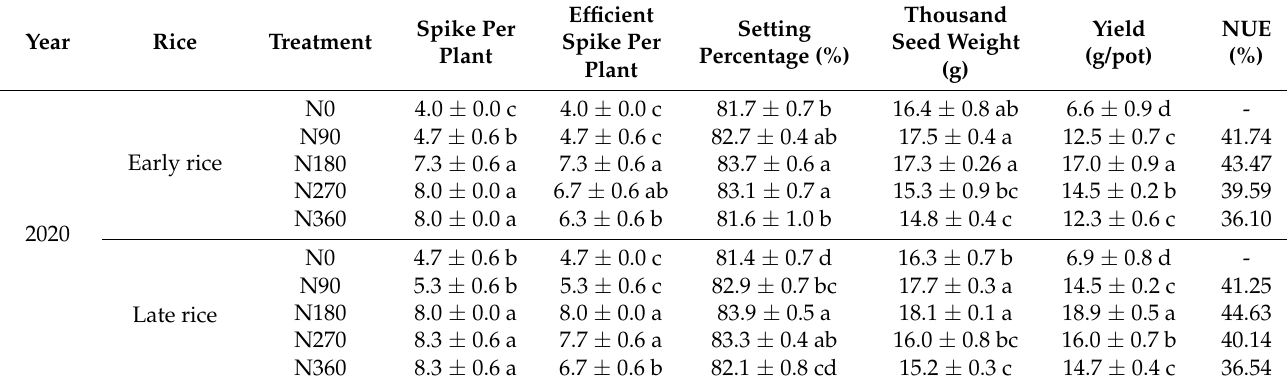
Values followed by a different lower-case letter in the same vertical column were statistically different ( p < 0.05; Duncan’s test). Early rice and late rice were compared